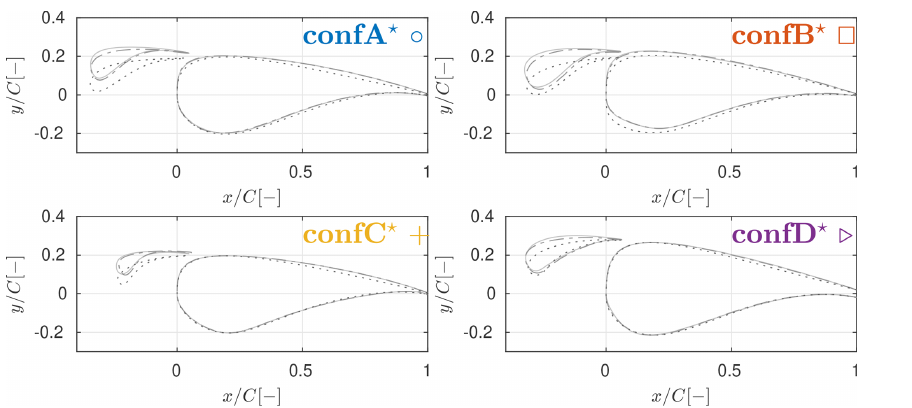
Figure 12. Designs obtained using the integral design procedure optimized for maximum lift ( − ), maximum glide ratio ( : ), and a combination of both ( − . ); see Fig. 8 for clarification.